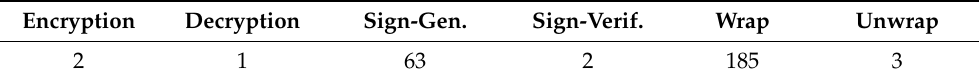
Table 1. Execution time of L2Sec functionalities on STM32L4S5VIT MCU with STSAFE-A110 disabled. Time is expressed in milliseconds (ms).